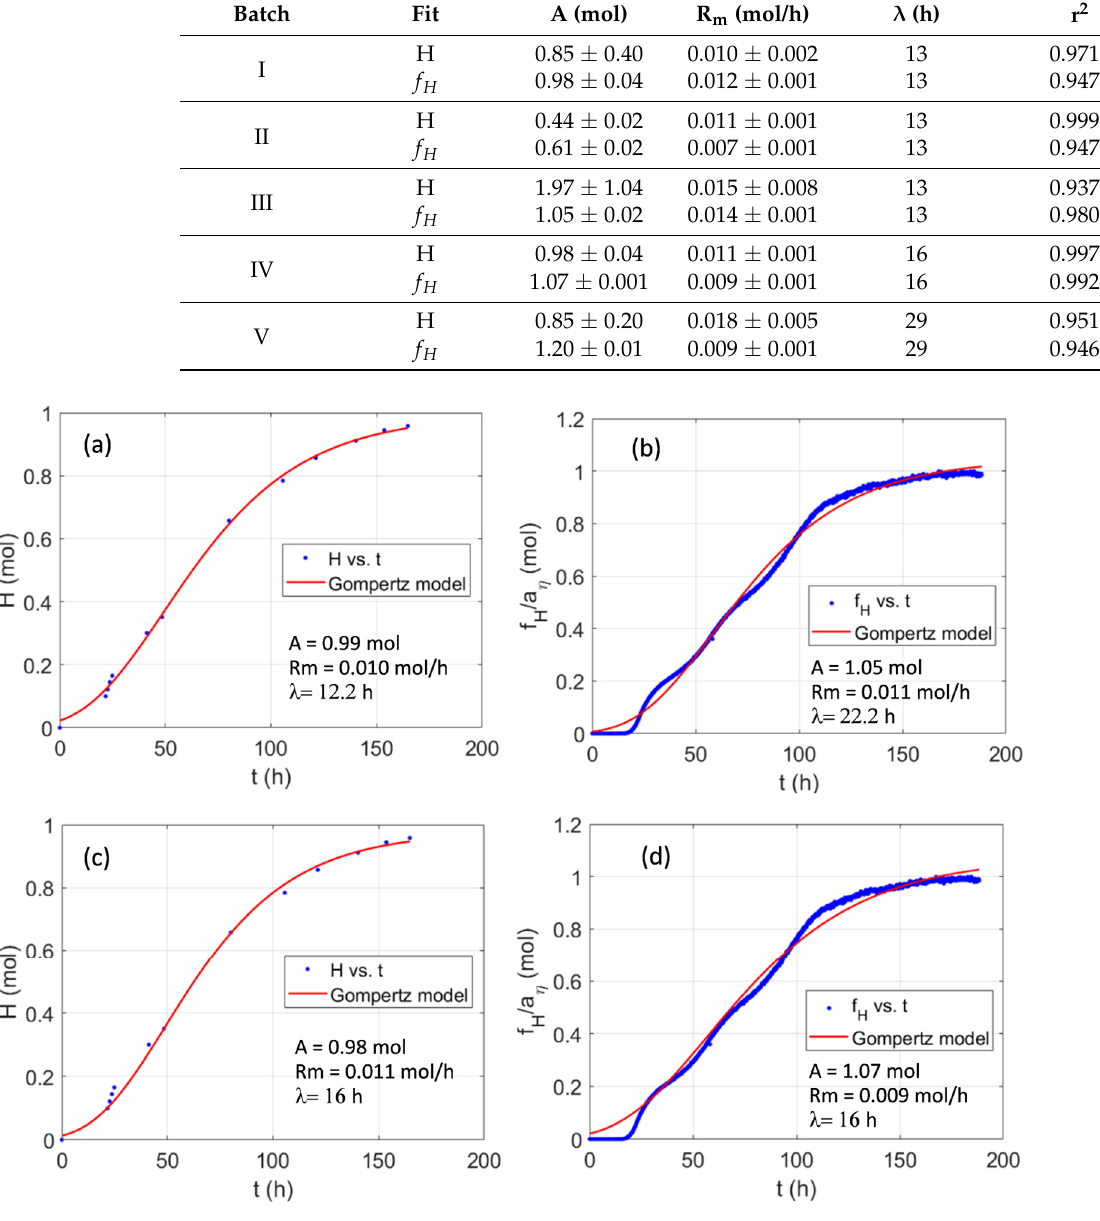
Figure 5. Comparison of the measured moles of H 2 in Batch IV ( a , c ) and the moles of hydro- gen estimated from the corresponding pH curve using the function f H and the relation given by Equation (13) ( b , d ) vs. the values predicted by the modified Gompertz model with three fitted param- eters ( a , b ) or two fitted parameters and the lag phase time estimated from the pH curve, as described before ( c , d